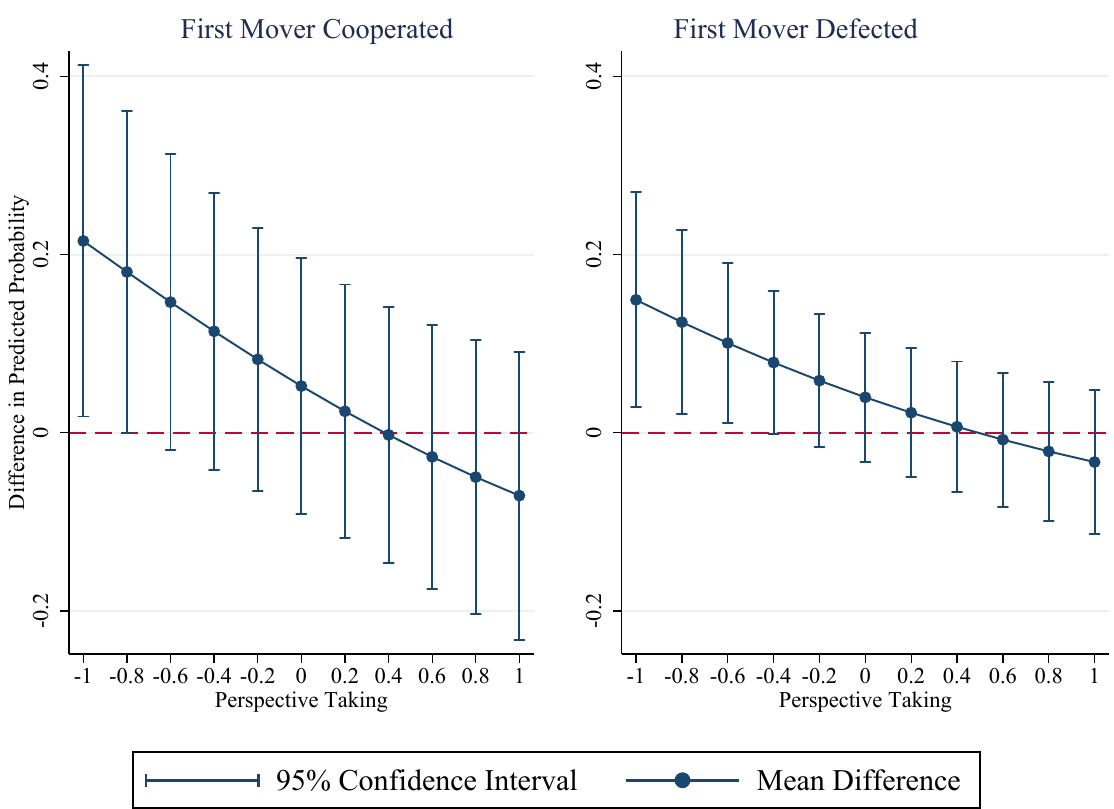
Figure 7. Mean Difference in Predicted Probability between Low Control and High Control conditions by Perspective Taking (First 10 Rounds and Known